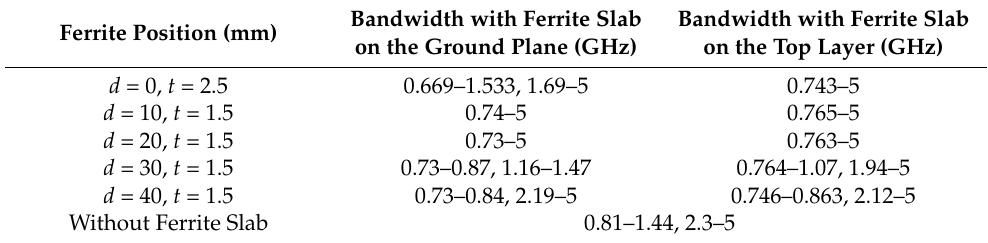
Figure 11. Frequency behavior of measured |S 11 | of the proposed antenna with ferrite slab on the top layer versus the ferrite’s position. Table 1. Bandwidth of the proposed antenna with ferrite slab mounted on the ground plane and the top layer at different positions.